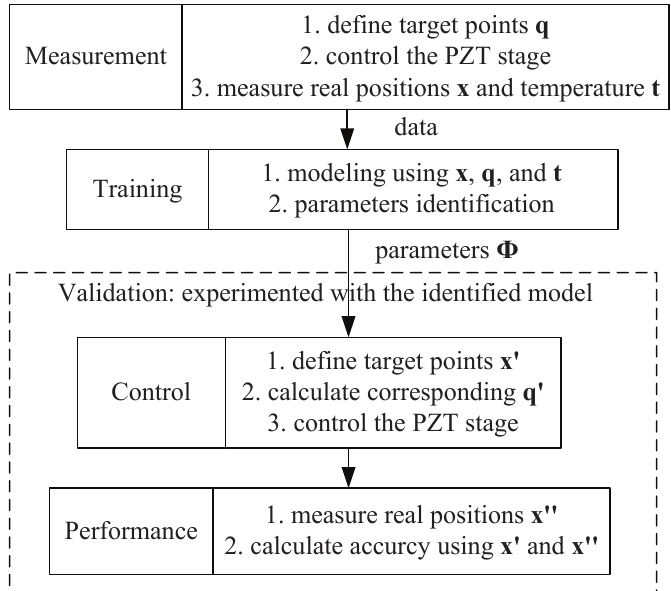
Figure 8. Flow chart of calibration of nanopositioning stages.